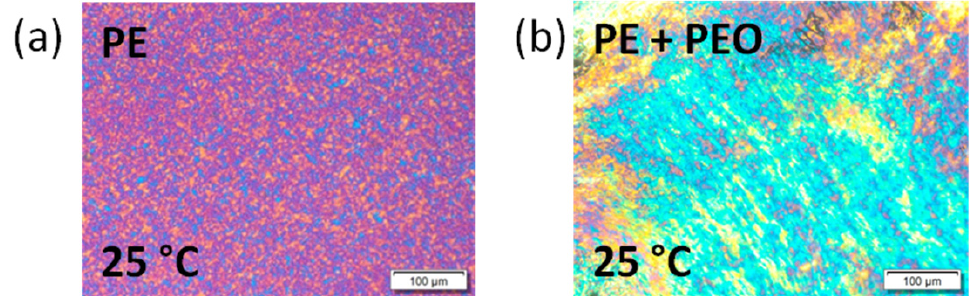
Figure 12. PLOM micrographs taken at room temperature after cooling the samples from the melt at 20 ◦ C/min for ( a ) PE 9.5 and ( b ) PE 529.5 - b -PEO 488.8 , indicating the crystallized blocks at room temperature. Figure 9a corresponds to the homopolymer PE 7.1 , showing very small spherulites. In Figure 9b, the PE 327.1 - b -PEO 6815.1 diblock copolymer shows large spherulites